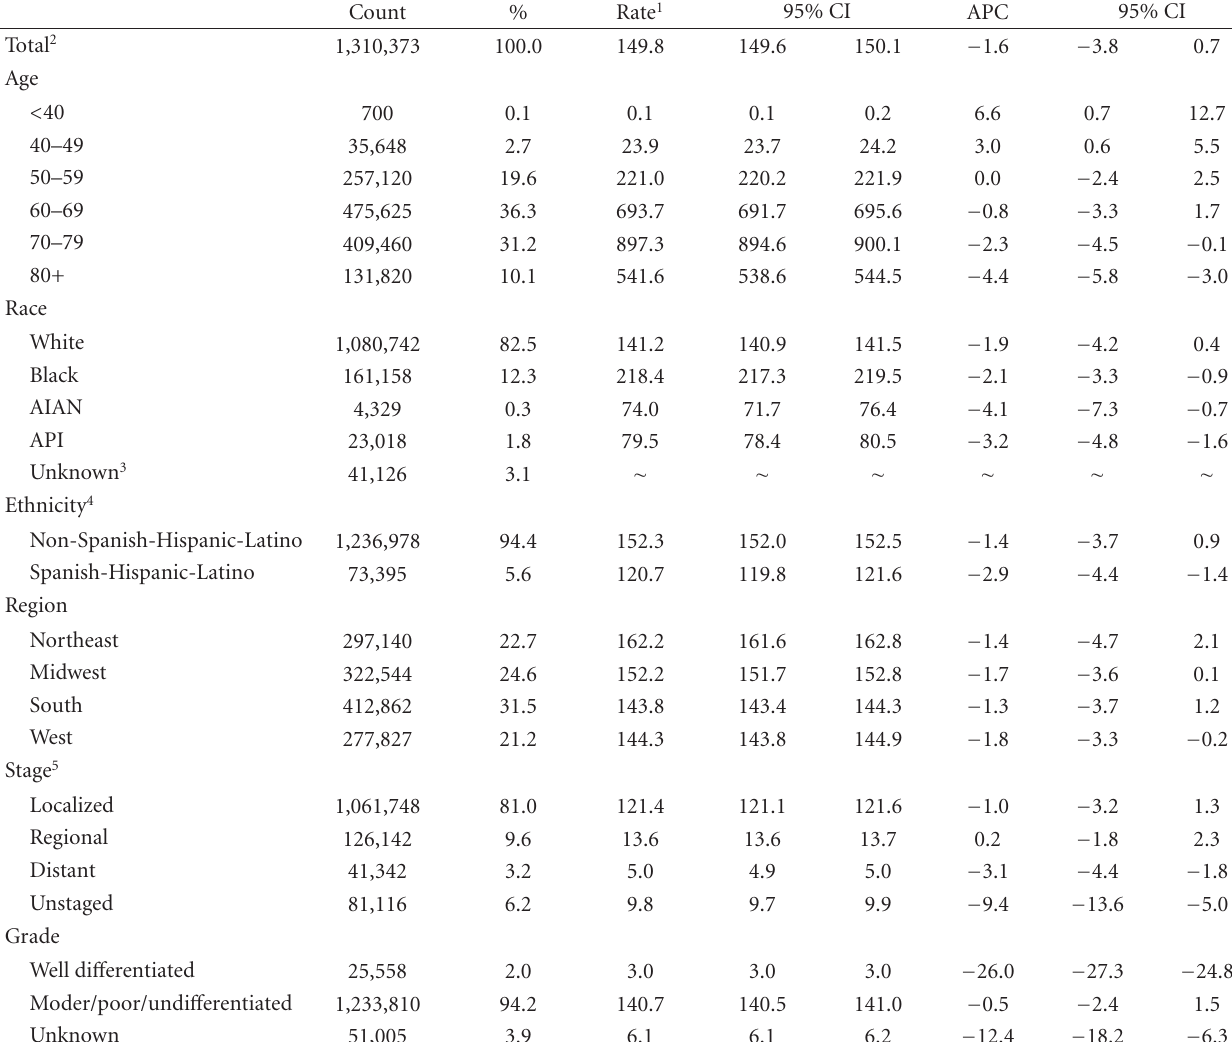
Table 1: Counts, incidence rates, and annual percentage changes in rates for prostate cancer by demographic and clinical characteristics, US men,